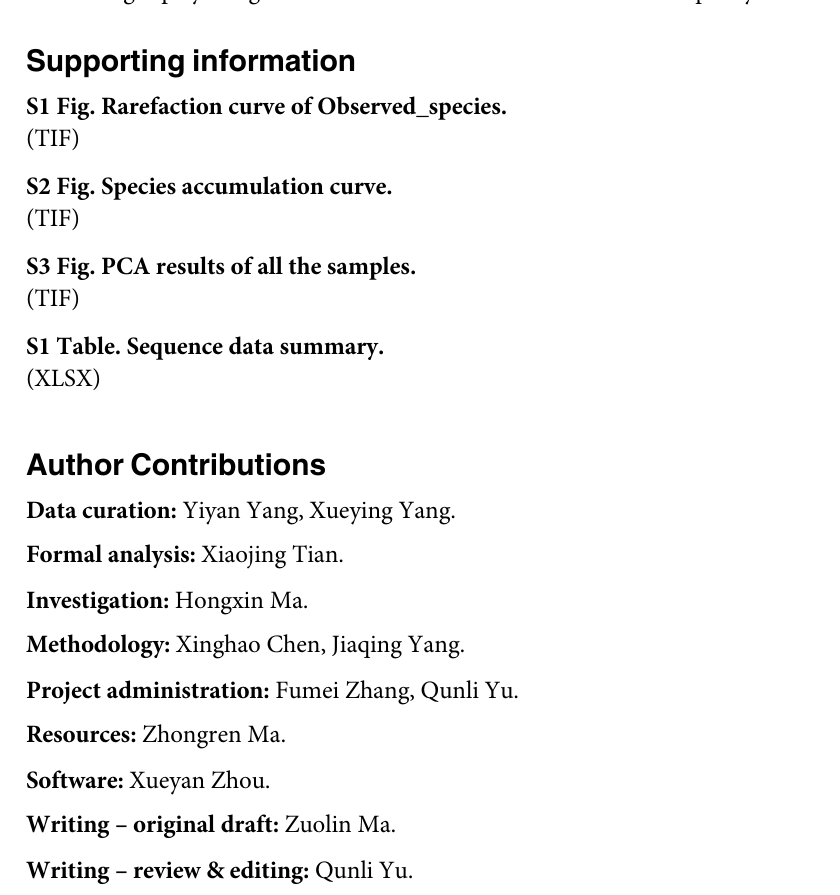
S1 Fig. Rarefaction curve of Observed_species. S2 Fig. Species accumulation curve. S3 Fig. PCA results of all the samples. S1 Table. Sequence data